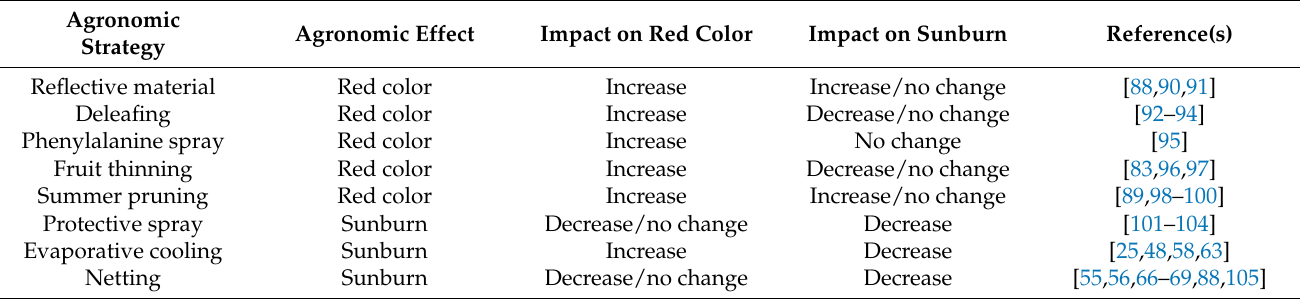
Table 2. Summary of the tradeoffs between red color and sunburn for a range of agronomic strategies to improve fruit quality in